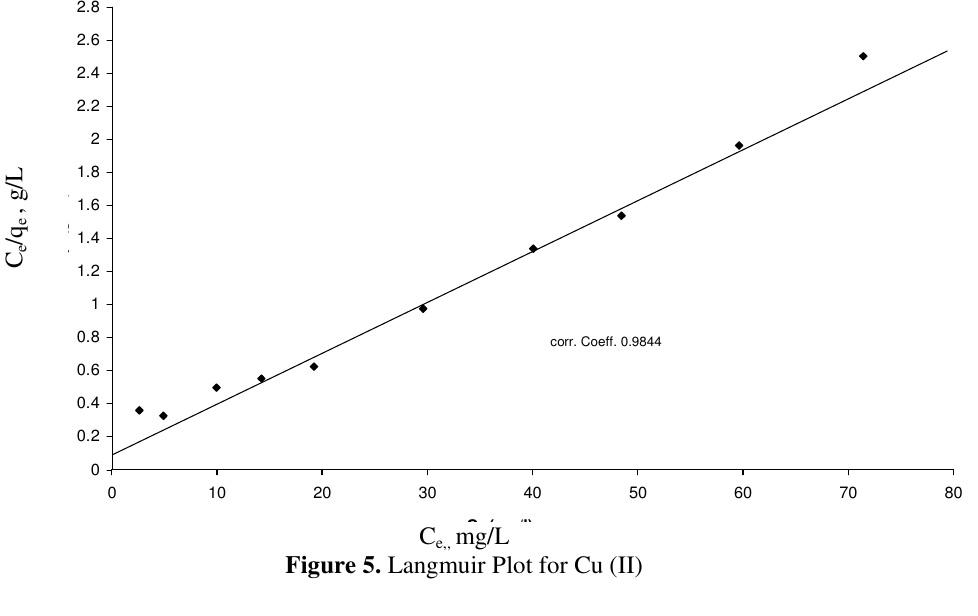
Figure 5. Langmuir Plot for Cu